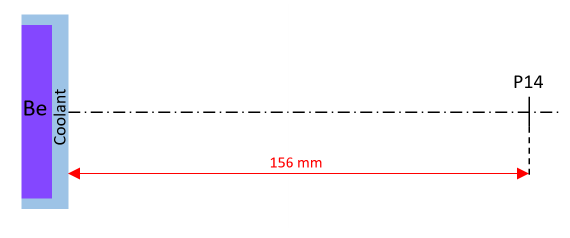
Figure 4. A schematic of the experimental arrange- ment.